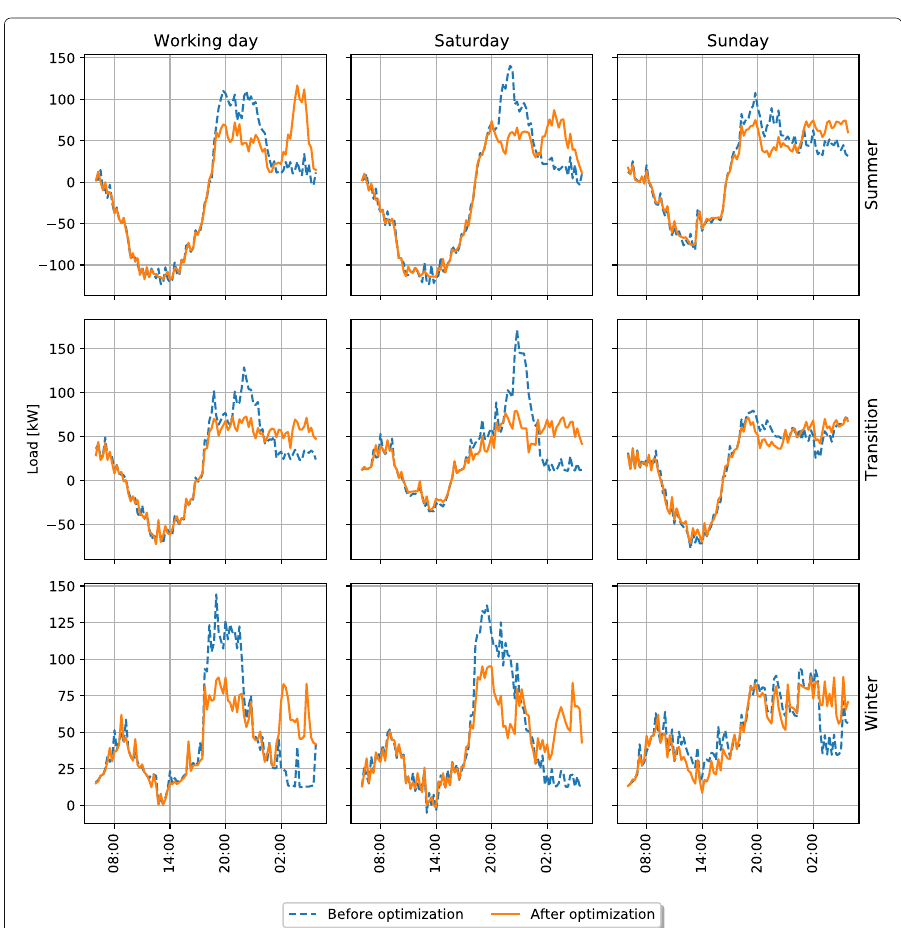
Fig. 2 Simulation results of the aggregated load of 32 interconnected units within the rural grid for